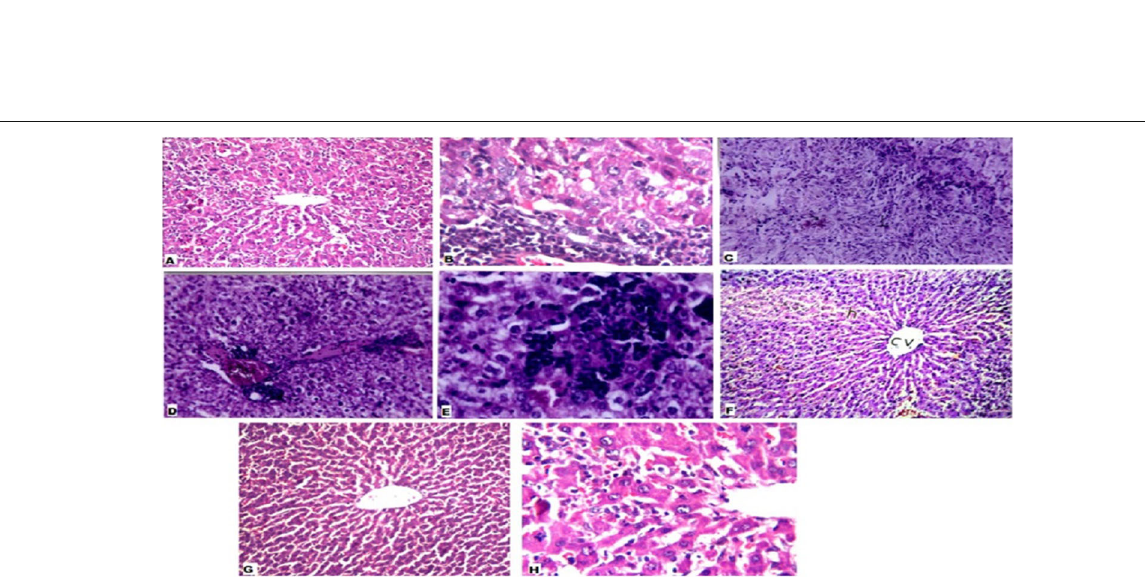
Fig. 6 Photomicrographs of rat livers. a Normal group. b – e TAA group, with the massive fibrosis, the fatty change was detected in the hepatocytes at the centrilobular area of the parenchyma surrounding the central vein. f – h Nano-Ag-BSEPS group, showed regression in periductal fibrosis and degradation of